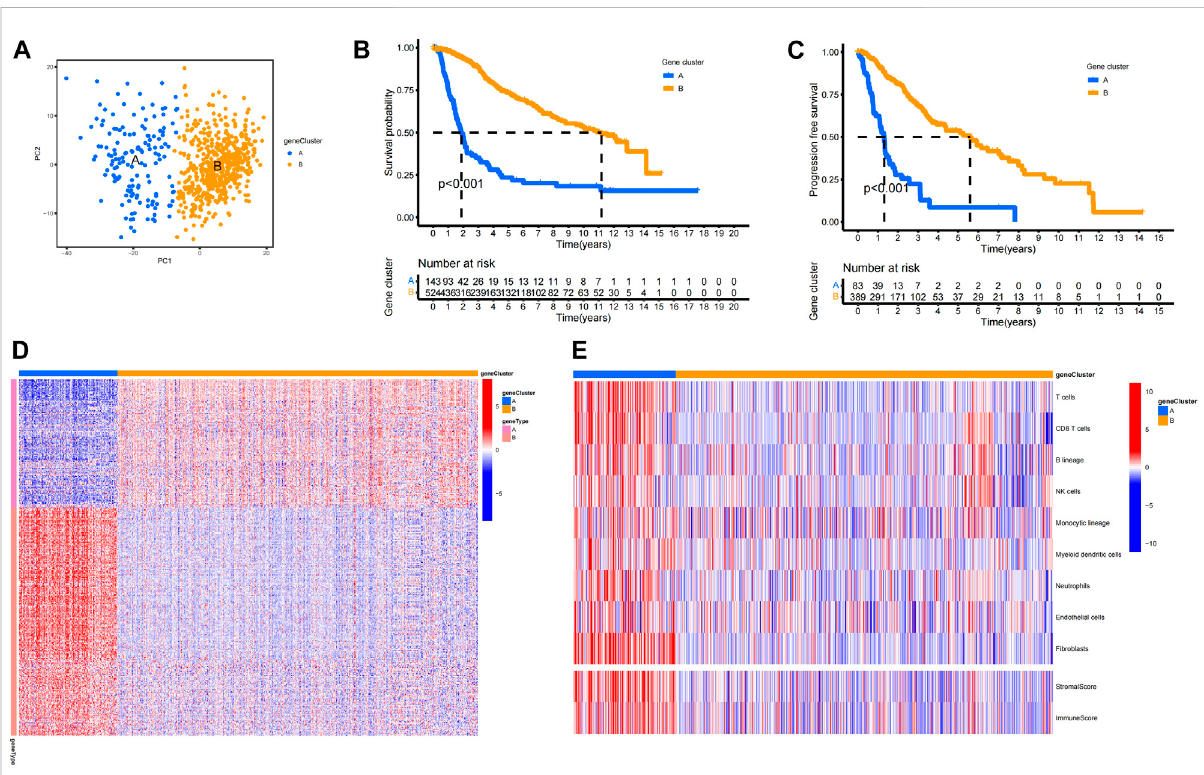
FIGURE 2 Aging CAF-related gene clusters. (A) PCA of LGG samples based on the expression pro fi les of ACAFRGs. Blue dots represent samples of gene cluster A and yellow dots represent samples of gene cluster B. (B) Kaplan – Meier analysis indicated that gene cluster A had a shorter overall survival than genecluster B( p < 0.001). (C) Kaplan – Meieranalysisindicated that genecluster A hadshorter progression-free survival than genecluster B( p < 0.001). (D) Heatmap displaying the distinct expression patterns of ACAFRGs between two gene clusters, in which gene type A was upregulated in gene cluster B while gene type B was upregulated in gene cluster A. (E) Heatmap displaying the distinct characteristics of the TME between two gene clusters. ACAFRGs, aging cancer-associated fi broblast related genes; LGG, low-grade glioma; PCA, principal component